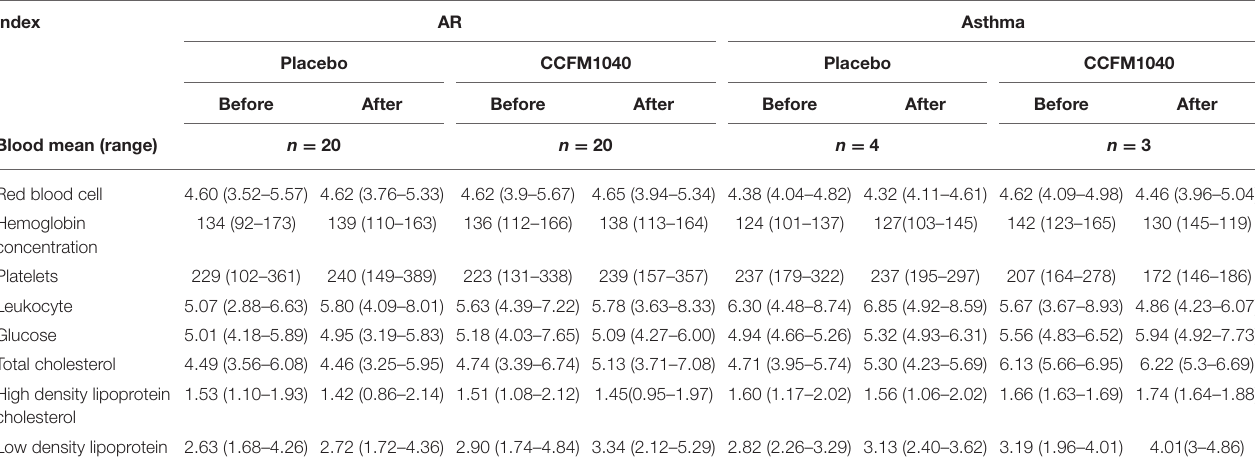
TABLE 2 | Blood and urine